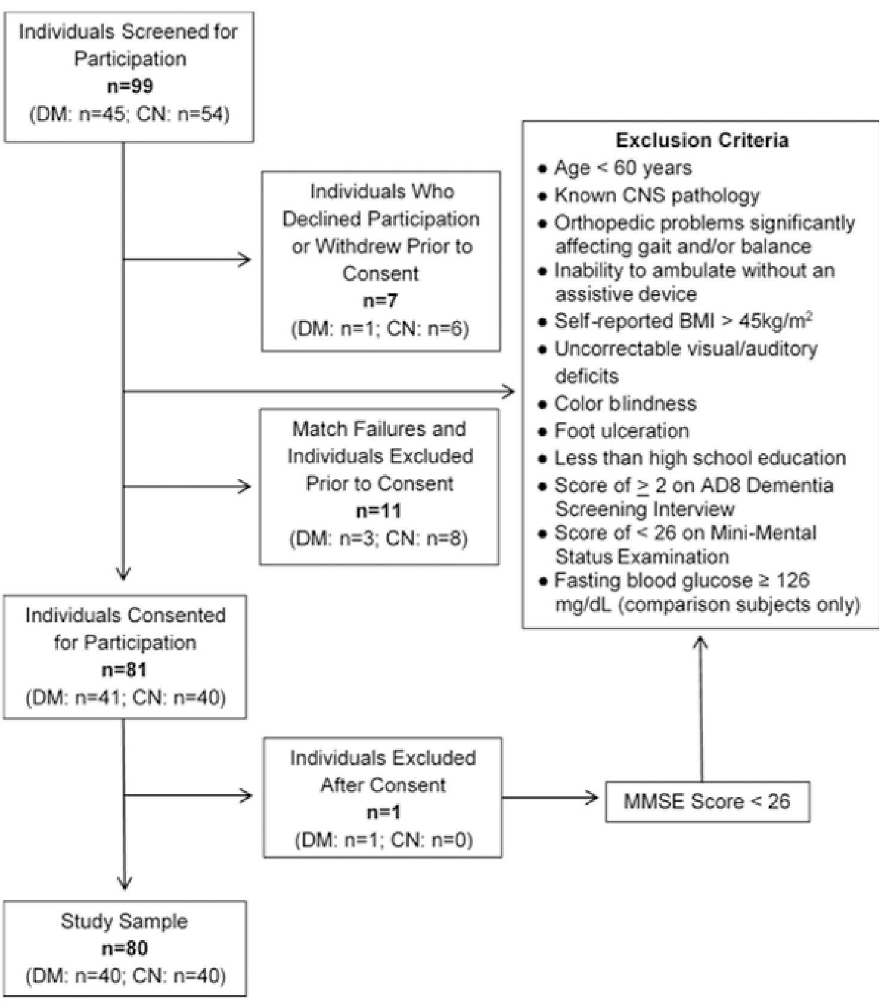
Fig 1. Study flowchart. Flowchart of participantsthroughout the study. Abbreviations: DM, type 2 diabetes mellitus; CN, comparison; CNS, central nervoussystem; BMI, body mass index; MMSE, Mini-Mental Status